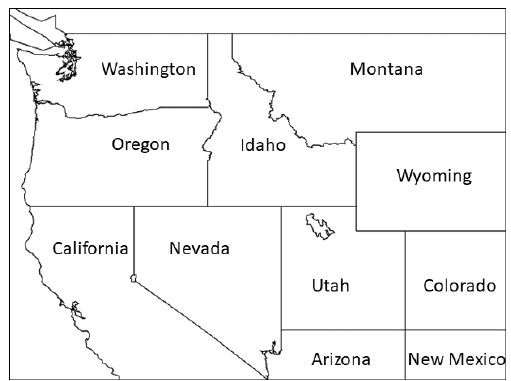
Figure 1. Study area covering all or parts of 11 states in the western US and part of southern Canada. This study area is 2487610km 2 in area. The base map was obtained from Inter- active Data Language (IDL) software that uses Natural Earth raster + vector map data, which are in the public